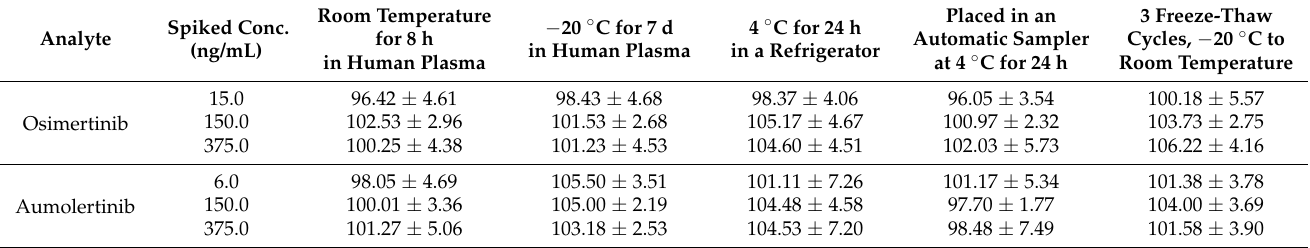
Table 3. Stability of analytes in human plasma under various storage conditions (mean ± SD, n = 6,